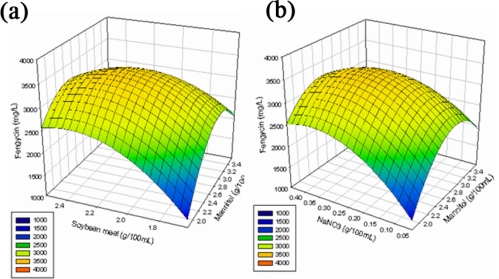
(a) Response surface curve based on mannitol and a soybean meal; (b) Response surface curve based on mannitol and NaNO3; (c) Response surface curve based on mannitol and MnSO4·4H2O; (d) Response surface curve based on a soybean meal and NaNO3; (e) Response surface curve based on a soybean meal and MnSO4·4H2O; (f) Response surface curve based on NaNO3 and MnSO4·4H2O.